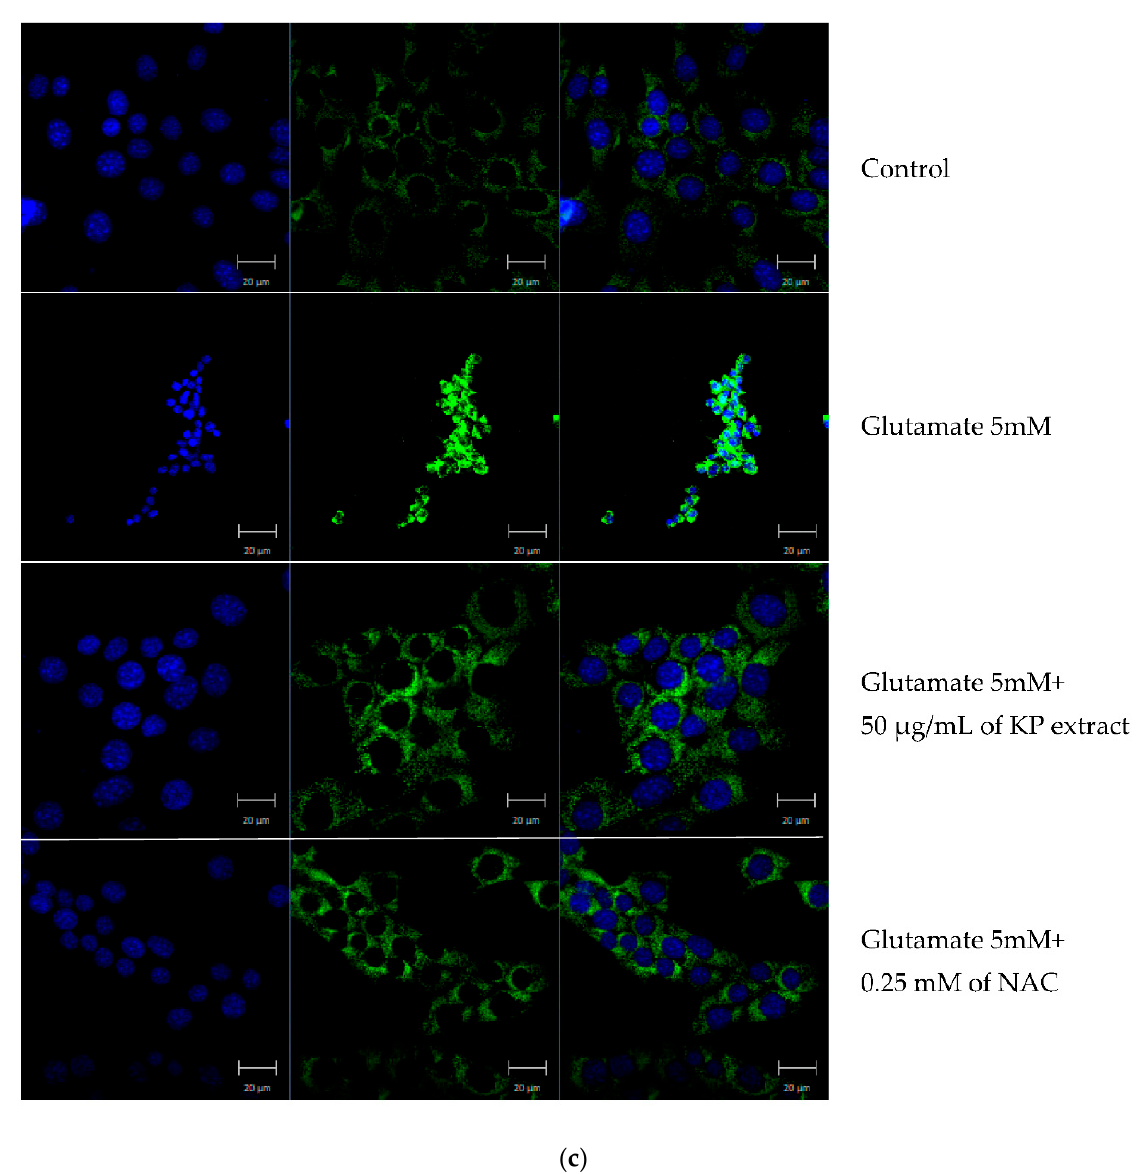
Figure 5. The effect of KP extract against glutamate-mediated cell death involves apoptotic-inducing factor (AIF) transloca- tion to the nucleus. HT-22 cells were exposed with 50 and 75 µ g/mL KP extract in the presence or absence of glutamate (5 mM) for 14 h, NAC (0.25 mM) was used as positive control. ( a ) Following incubation, nuclear and cytoplasmic fractiona- tion was performed and all targeted proteins (then, nuclear AIF, cytoplasmic AIF, Lamin B1, and β -actin were analyzed using Western blot analysis; ( b ) bars represent the fold-change of nuclear and cytoplasmic AIF expression. Lamin B1 and β -actin were used as an internal control to normalize protein expression for nuclear extracts and whole cell/cytoplasmic extracts, respectively. All data are expressed as the mean ± SEM (n = 3), ### p < 0.001 vs. control, * p < 0.05, and ** p < 0.01 vs. glutamate alone. The symbol “-” and “+” are defined as absent and present, respectively; ( c ) confocal laser scanning microscope images of AIF immunoreactivity (green) and nuclear Hoechst 33342 staining (dark blue). Co-treatment with KP extract resulting in prevention of nuclear AIF translocation after 14 h of 5 mM of glutamate